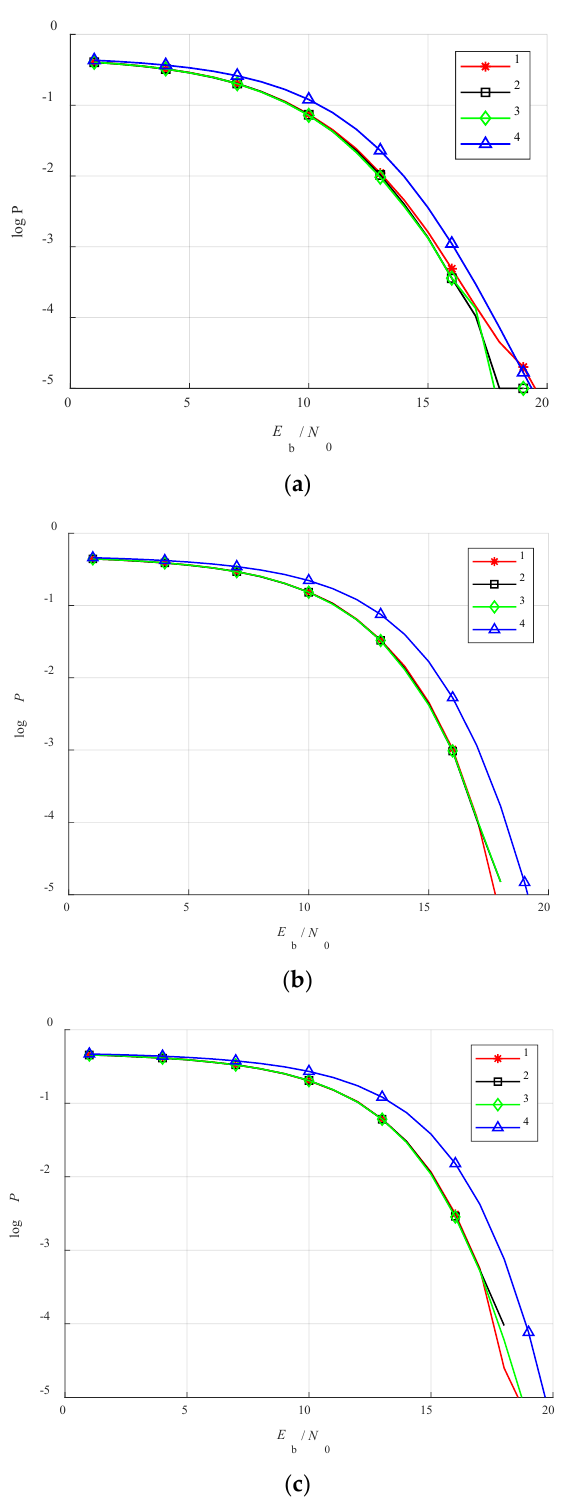
Figure 10. Bit error probability as a function of E b / N 0 at the processing gain: ( a ) K =100; ( b ) K = 300; ( c ) K = 500. Curves 1, 2, 3 correspond to simulations with the following distributions: 1—Gaussian, 2—uniform, 3—telegraph. Curve 4 is the analytical estimate.